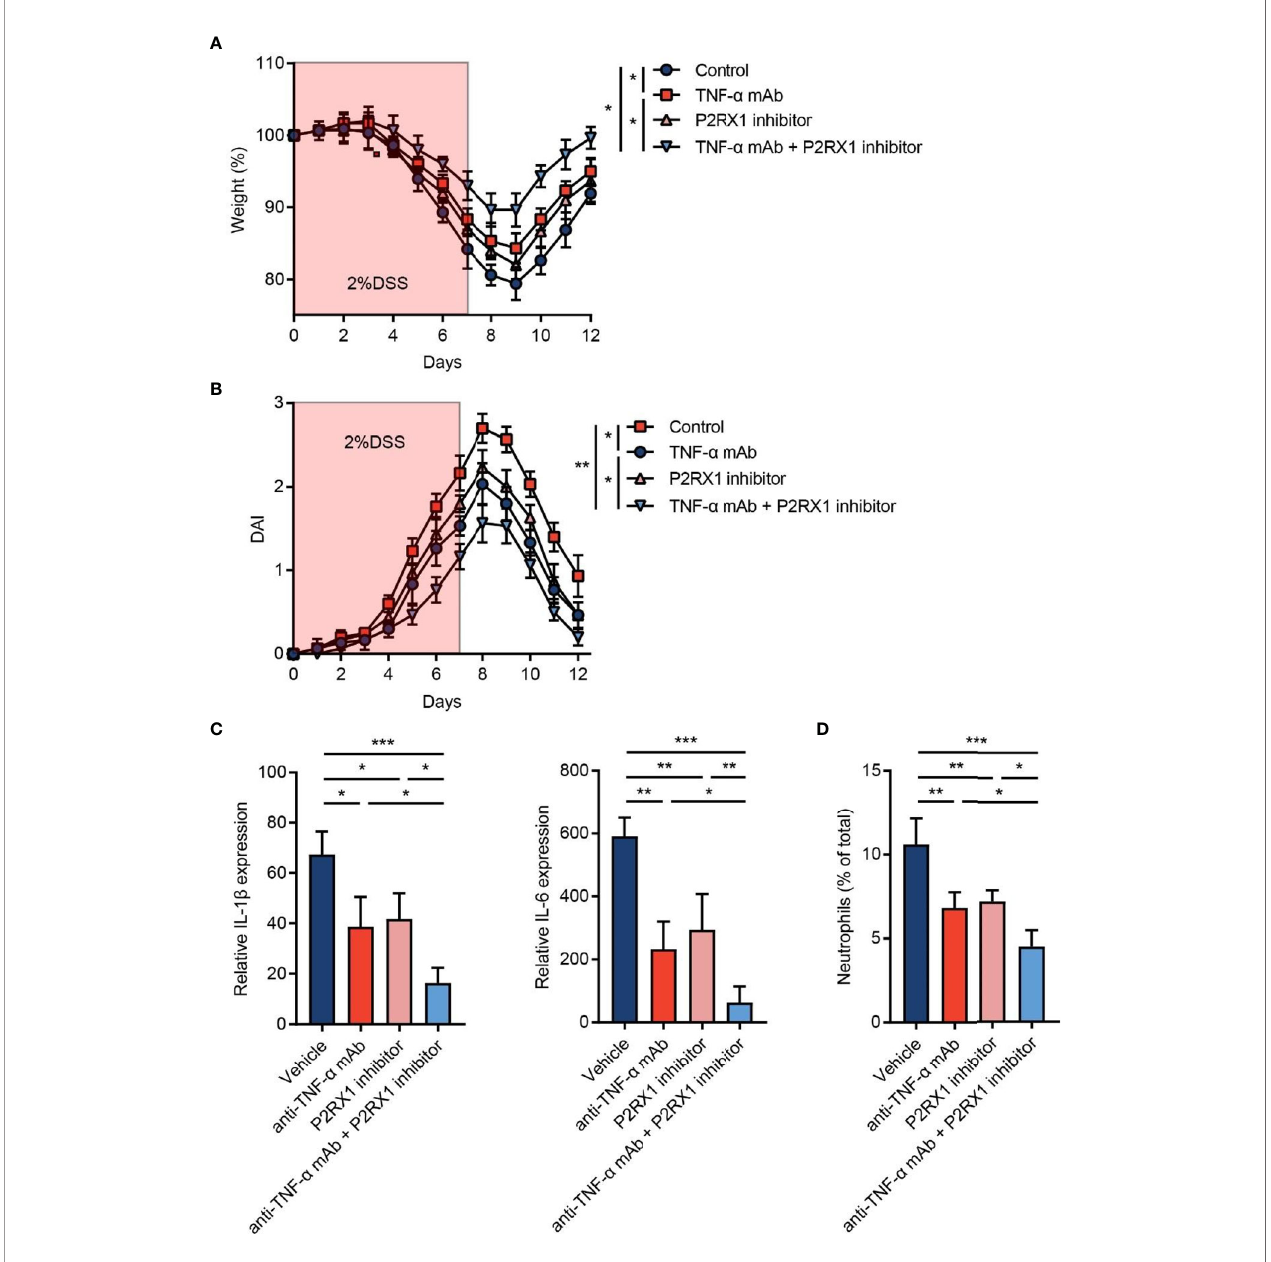
FIGURE 5 | Inhibition of P2RX1 promotes the ef fi ciency of anti-TNF- a therapy in mouse colitis. (A, B) WT mice were treated with 2% DSS for 7 days. Anti-TNF- a monoclonal antibody (mAb) (0.1 mg/day) or/and P2RX1 inhibitor (NF449, 10 mg/kg/day) was/were administrated for 7 days. Weight loss (A) and disease activity index (DAI) (B) were calculated (n = 6 per group). Statistical analyses were performed at day 7. (C) At day 7, RT-qPCR was performed to detect in fl ammatory cytokine expression (n = 4 per group). (D) At day 7, colonic neutrophils were determined by cytometry (n = 4 per group). *P < 0.05, **P < 0.01, and ***P <